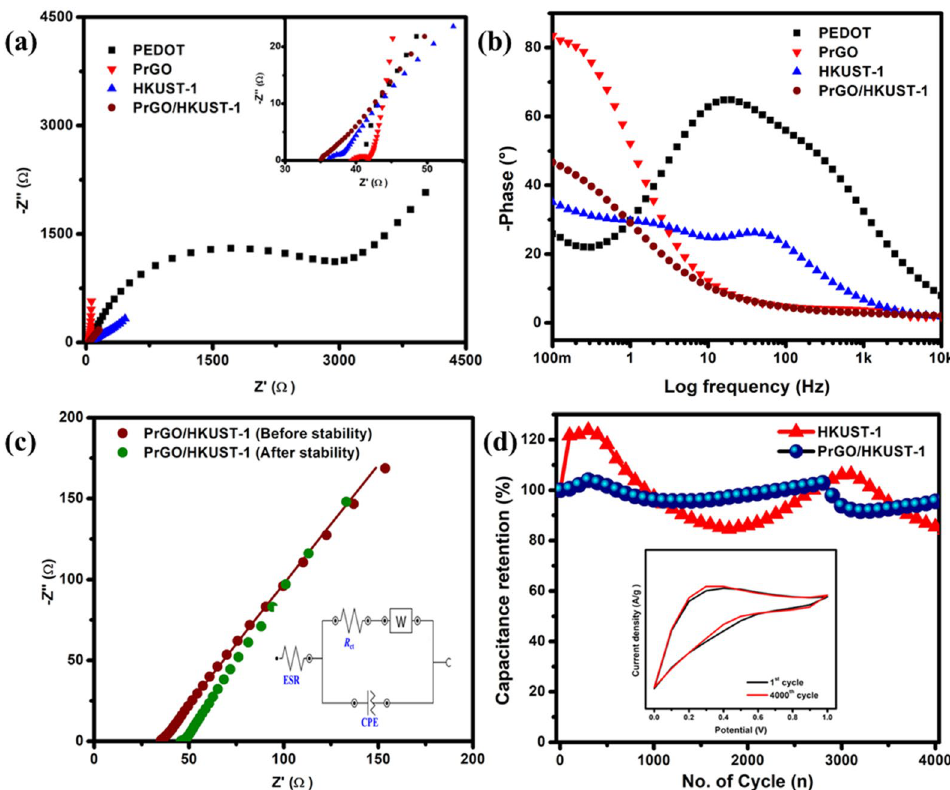
Figure 7. ( a ) Nyquist and ( b ) Bode plots of PrGO, PEDOT, HKUST-1 and PrGO/HKUST-1 between 0.1 Hz and 10 kHz (inset displays at high-frequency region). ( c ) Nyquist plots of PrGO/HKUST-1 (before and after stability) with an equivalent circuit and ( d ) cycling stability over 4000 cycles at 100 mV/s (Inset: CV curves of PrGO/HKUST-1 at 1 st and 4000 th